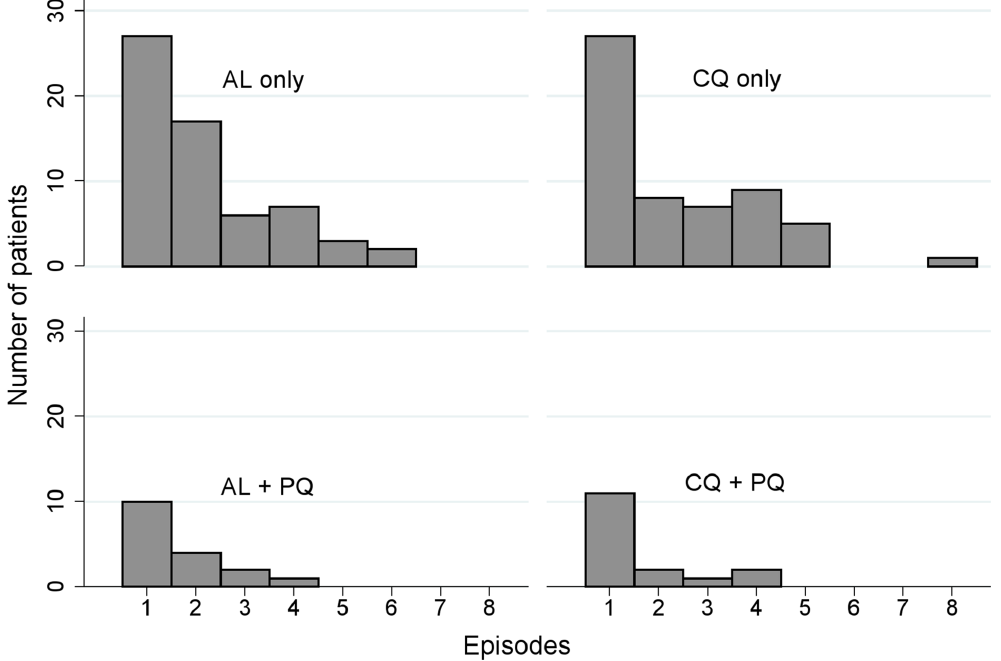
Fig 3. Histogram of the distribution of the number of recurrent P . vivax infections occurring during the 1-y follow-up period. AL, artemether-lumefantrine; AL+PQ, artemether-lumefantrine + primaquine;CQ, chloroquine; CQ+PQ, chloroquine+